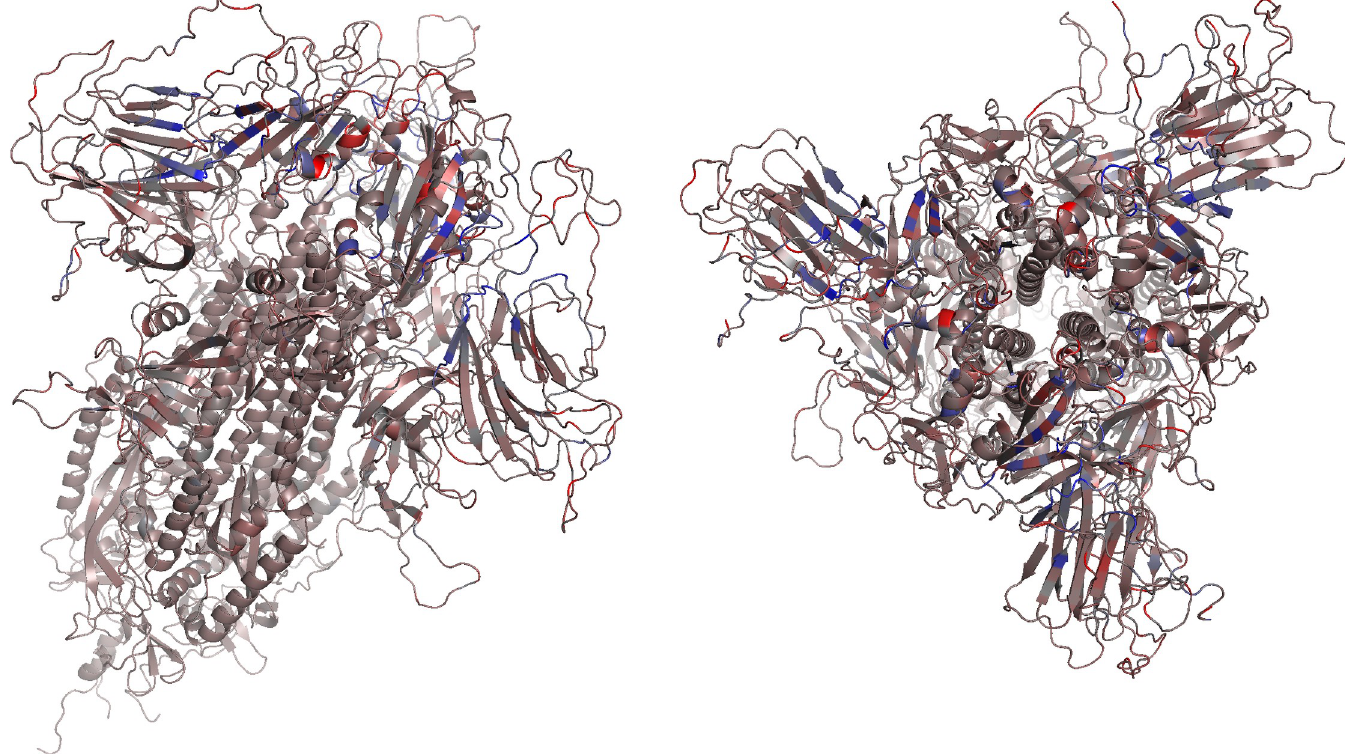
Fig 7. VDS values represented in the structure of Spike from two angles according to the median value for each position and the same color scheme as in the Difference Score Heatmap (Fig 6B).